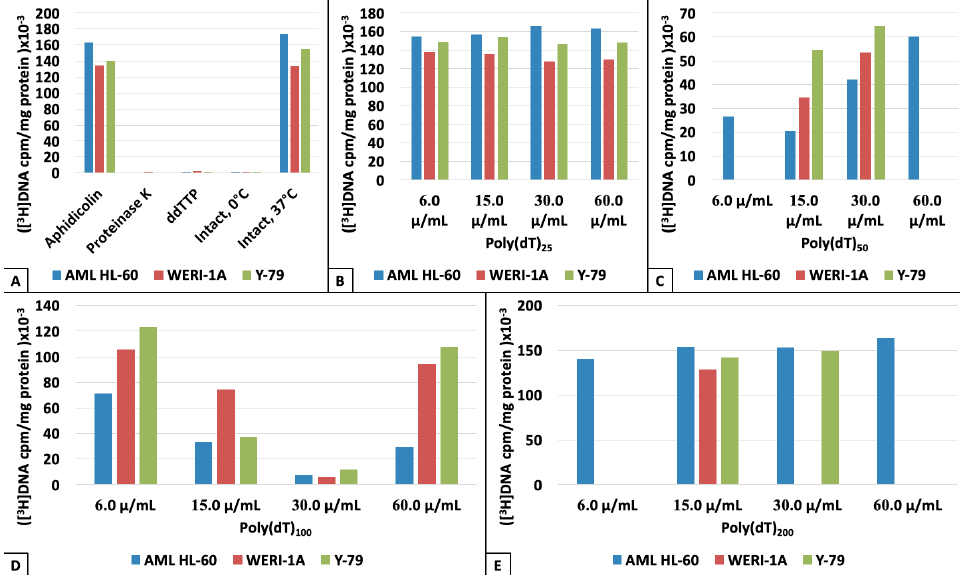
Figure 2. ( A ) Catalytic activities of beta-like DNA polymerases from HL-60, WERI-1A and Y-79 cancer cells under optimal and modified incubation conditions. ( B ) Catalytic activities of beta-like DNA polymerases from HL-60, WERI-1A and Y-79 cancer cells in the presence of Poly(dT)25. ( C ) Catalytic activities of beta-like DNA polymerases from HL-60, WERI-1A and Y-79 cancer cells in the presence of Poly(dT)50. ( D ) Catalytic activities of beta-like DNA polymerases from HL-60, WERI-1A and Y-79 cancer cells in the presence of Poly(dT)100. ( E ) Catalytic activities of beta-like DNA polymerases from HL-60, WERI-1A and Y-79 cancer cells in the presence of Poly(dT)200.